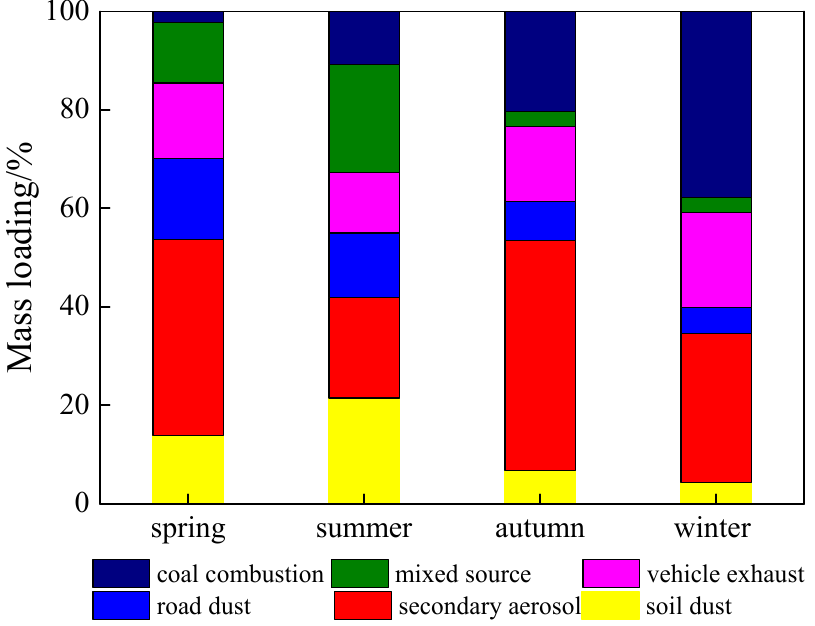
Figure 7. Contribution percentage of the identified sources to PM 2.5 in the four seasons.